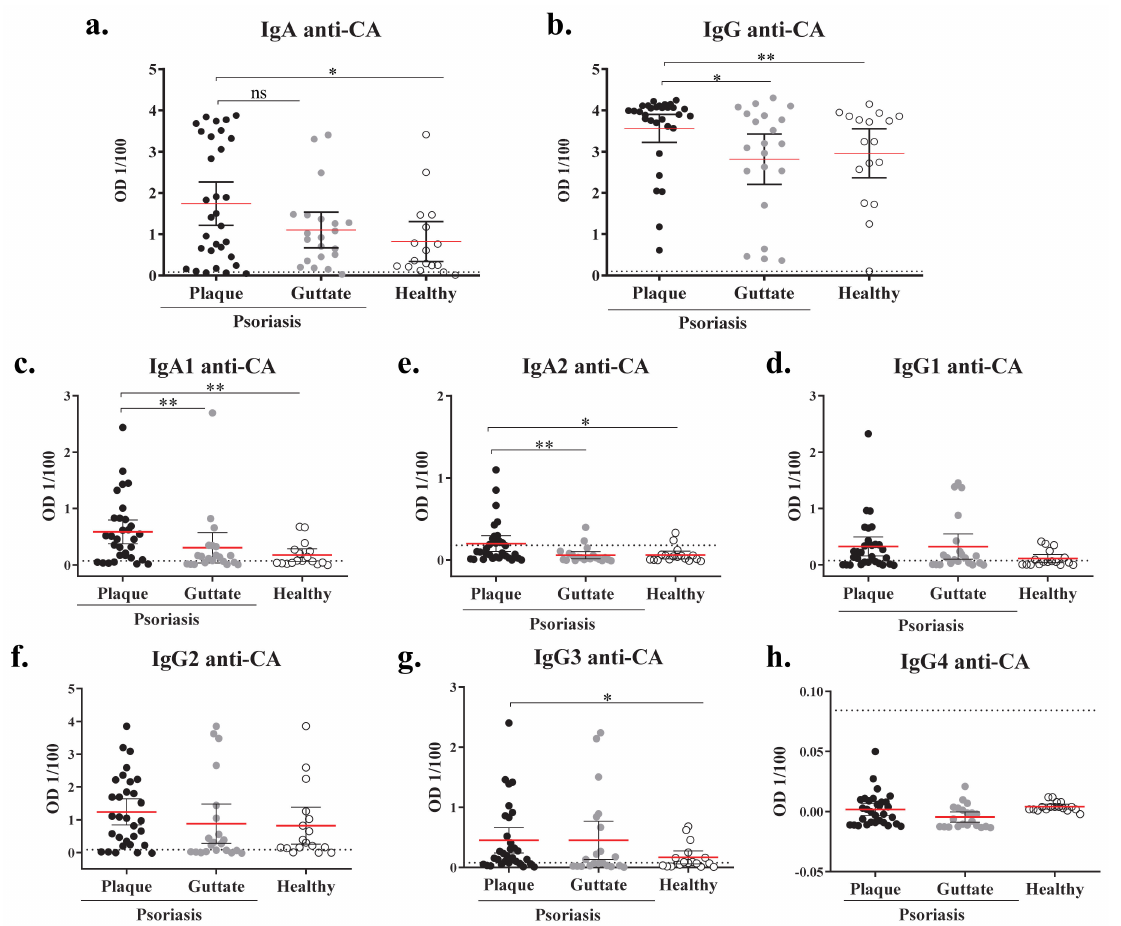
Figure 1. Plaque, but not guttate, psoriasis patients present increased IgA-1, IgA-2 and IgG-3 against Candida albicans compared to healthy controls. Specific immunoglobulins recognizing C. albicans cellular antigens (CA) were detected through ELISA in plasma collected from the blood of plaque psoriasis ( n = 31, • ), guttate psoriasis ( n = 21, • ) and healthy controls ( n = 17, ). Net OD of 1/100 diluted plasma is reported. Plasma levels of IgA ( a ), IgA-1 ( b ), IgA-2 ( c ), IgG ( d ), IgG1 (cid:35) ( e ), IgG2 ( f ), IgG3 ( g ) and IgG4 ( h ) against CA are shown. Statistics lines are represented as mean with 95% confidence interval. Dotted lines indicate the mean background signal. A Mann–Whitney test was used to compare between groups, and p values are indicated as: ns: p > 0.05; *: p < 0.05; **: p <